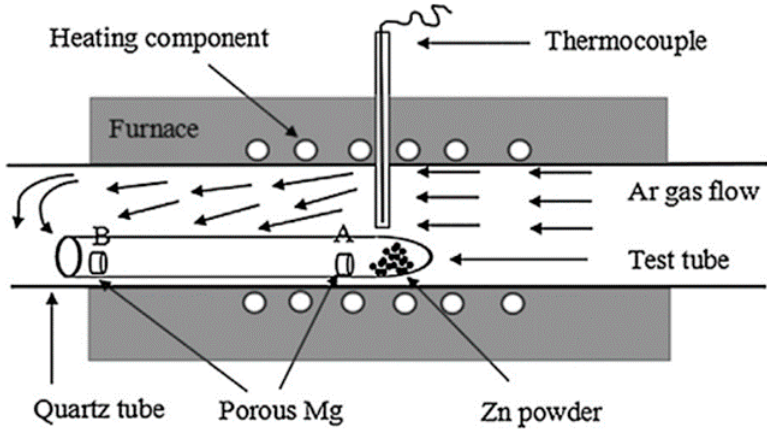
Figure 9. Schematic diagram of thermal evaporation apparatus. Reprinted from Reference [91] with permission from Elsevier.